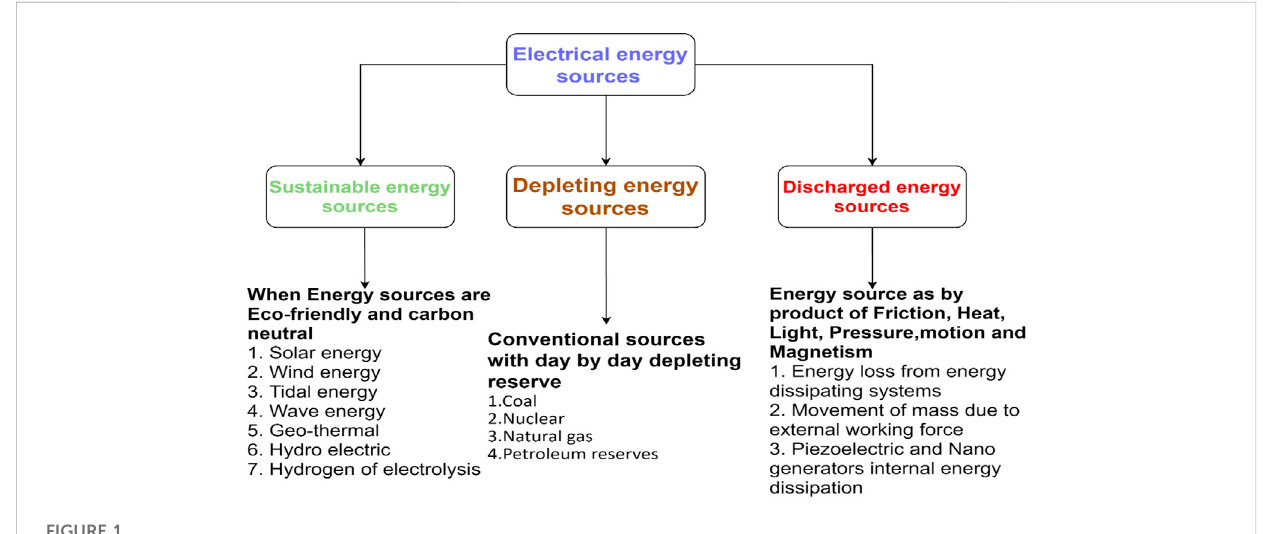
FIGURE 1 Reclassi fi cation of electrical energy